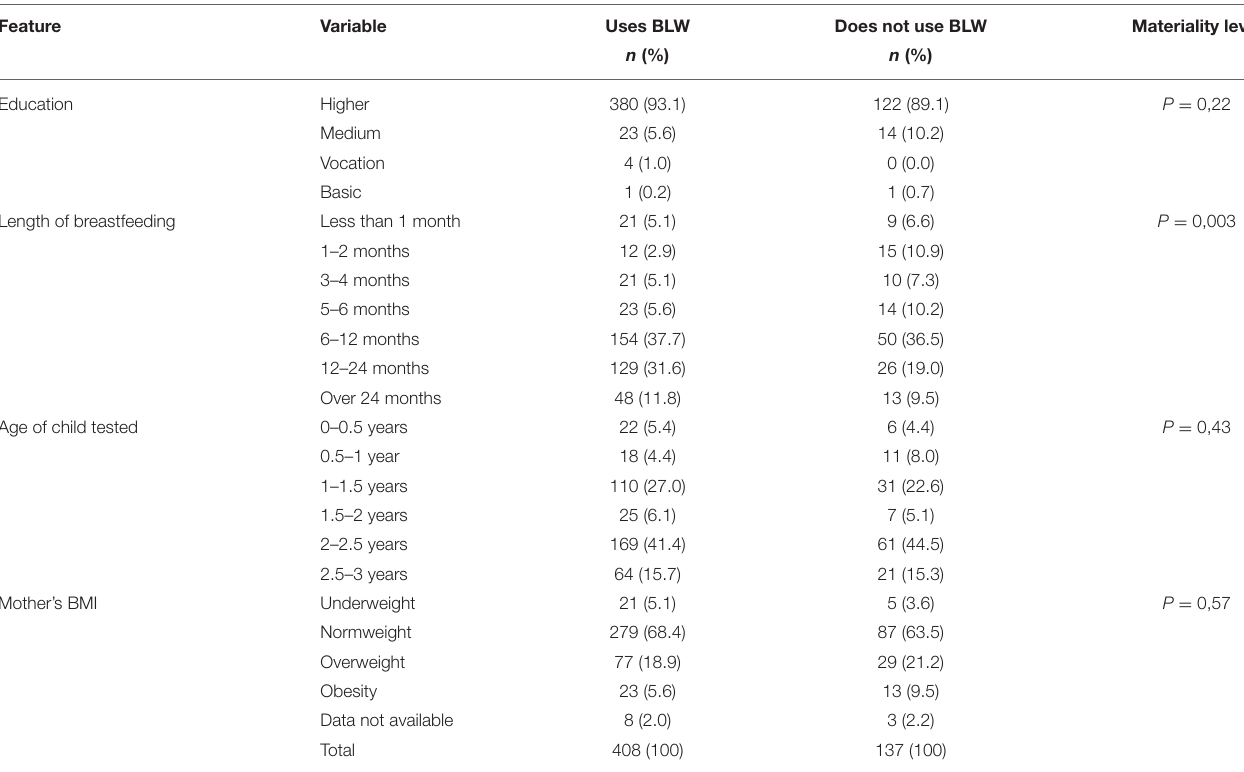
TABLE 8 | Relationship between BLW use and sociodemographic factors.